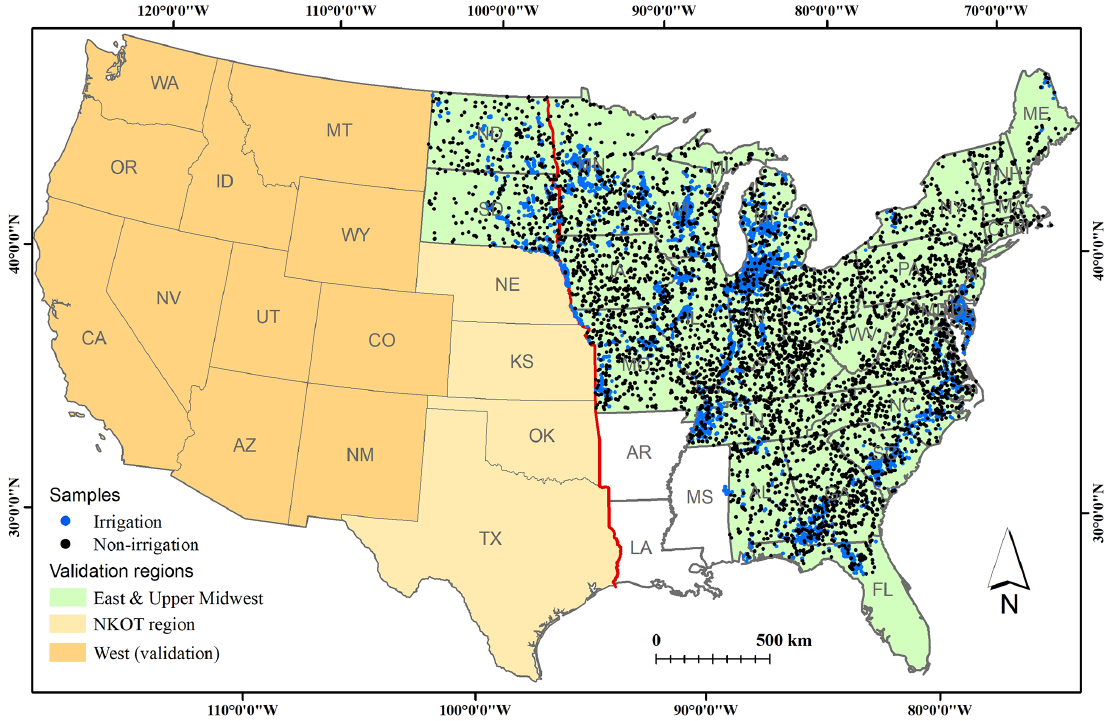
Figure 2. Map evaluation and comparison design and the distribution of test sample locations across the eastern CONUS. The NKOT region refers to Nebraska, Kansas, Oklahoma, and Texas, which covers the majority of the High Plains aquifer. The red solid line represents the west–east division for classification